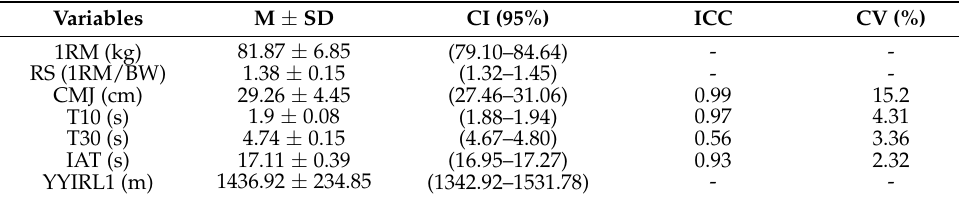
Table 1. Physical fitness variables ( n = 26).